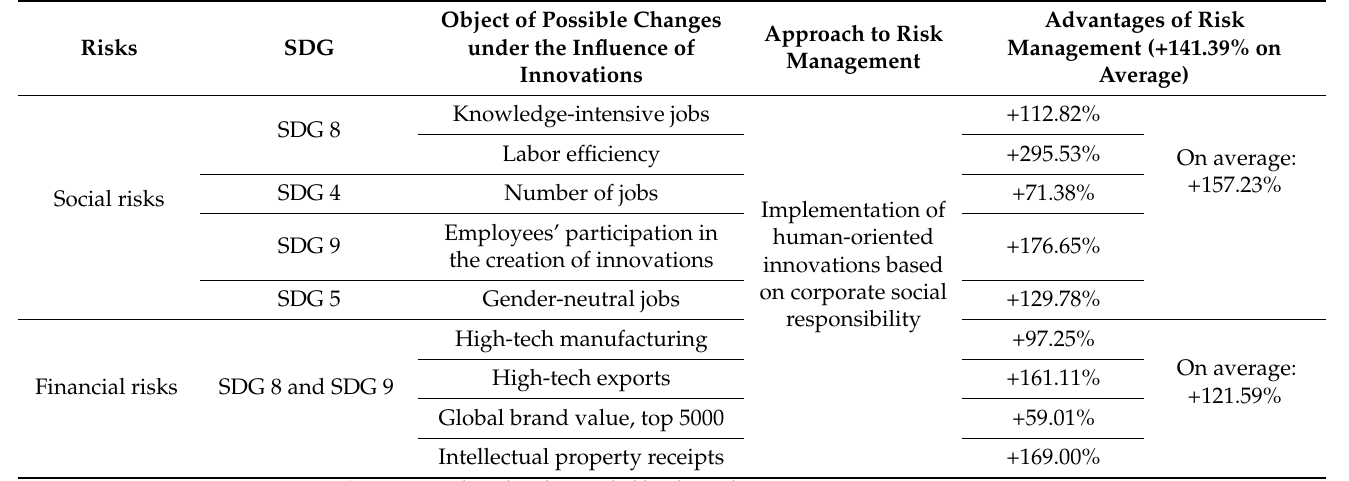
Table 11. Advantages of the systemic risk management of investments in innovation based on corporate social